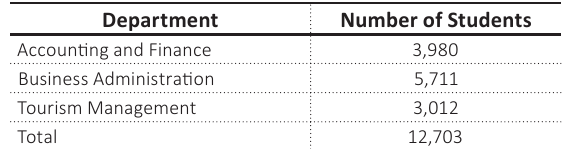
Table 1. Distribution of student population by